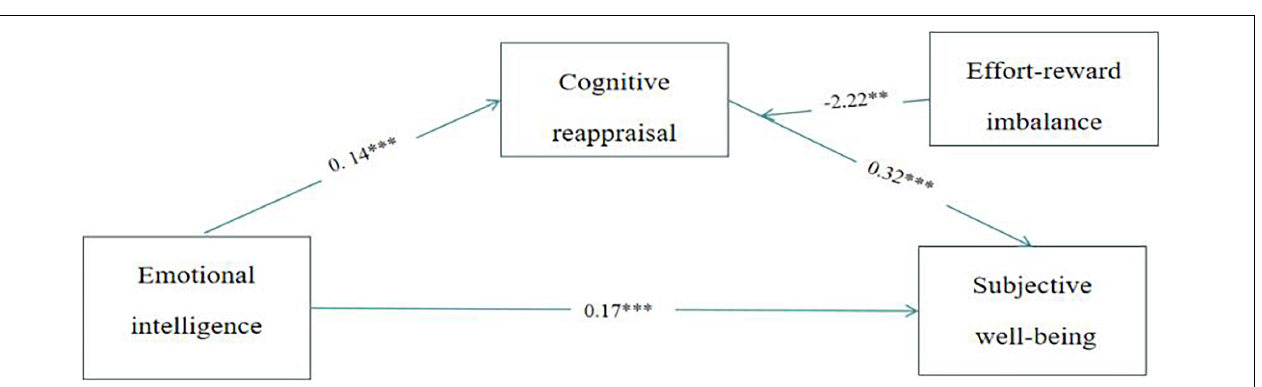
FIGURE 1 | The relationship models of EI, emotional regulation strategies, and SWB. *** p < 0.001.